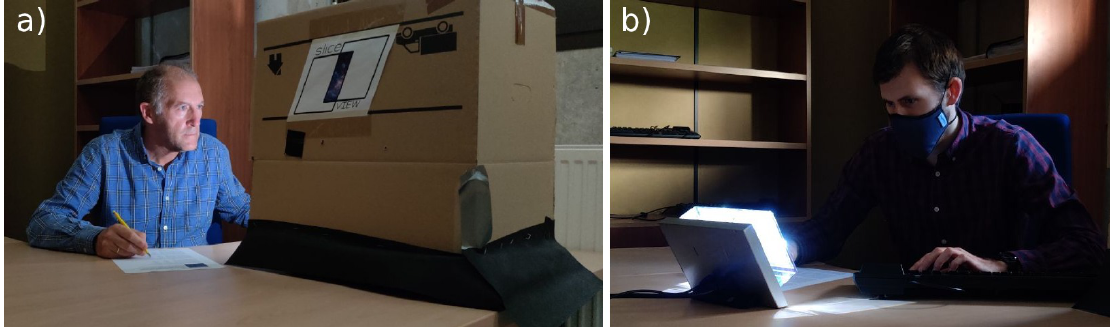
Figure 7. ( a ) Participant using SliceView to perform several tasks. ( b ) Participant using LookingGlass to perform several